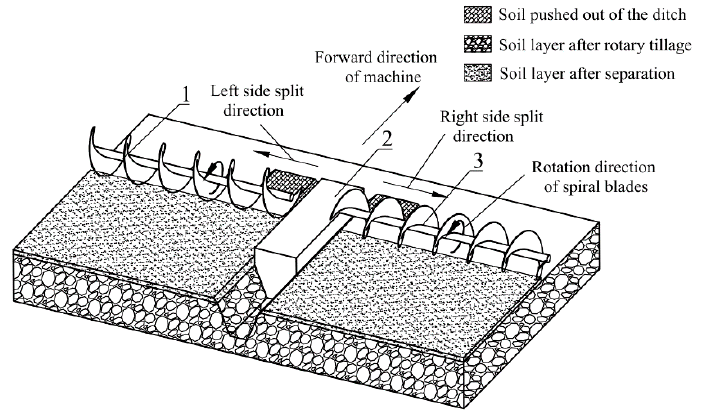
Figure 2. Working process of SSSM. 1. Left spiral blades. 2. Ditching. 3. Right spiral blades.